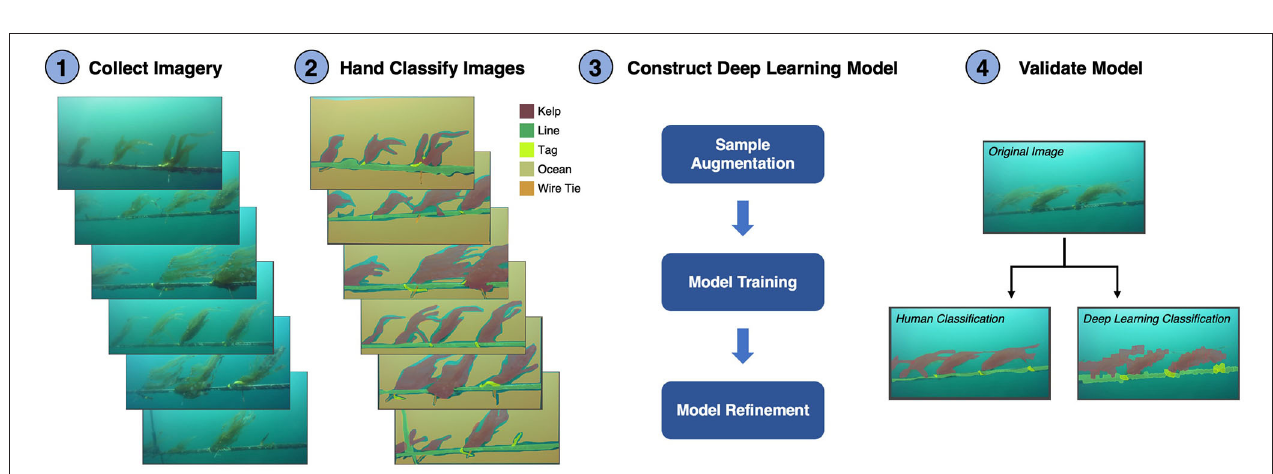
FIGURE 5 | (A) Histogram showing the number of pneumatocysts per individual determined from video captured by a remotely operated vehicle (ROV) on a section of each line at each date. (B) Side scan sonar imagery of the line on July 12 and July 30, 2019 showing farm structures and a drifting kelp frond caught on the farm buoy. Insets inside the orange boxes show enlarged areas of sonar returns along the farm lines between the two dates. Orange arrows show high acoustics returns at the locations of probable kelp outplants. Color images captured by the ROV showing typical size of individual kelp outplants for each date.